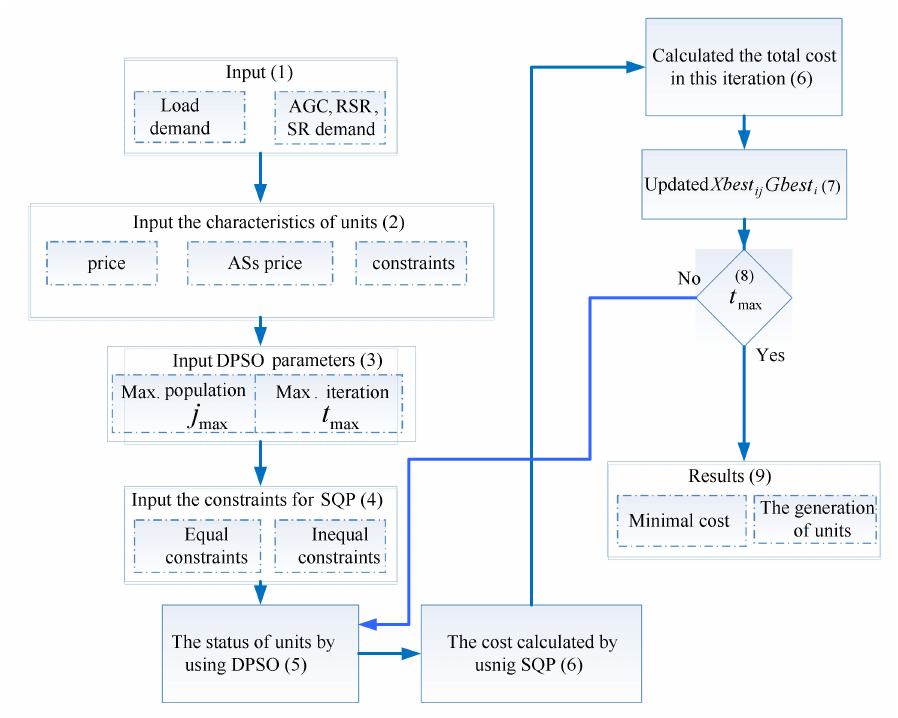
Figure 1. Flow chart of DPSO-SQP applied to unit commitment with ancillary